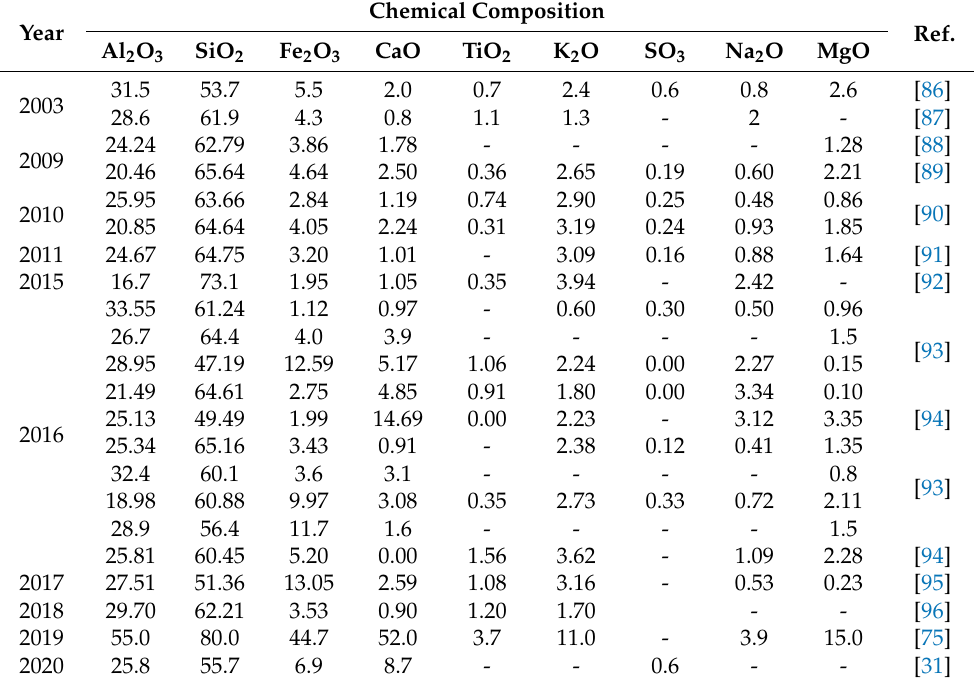
Table 5. Chemical composition of FA reported in different